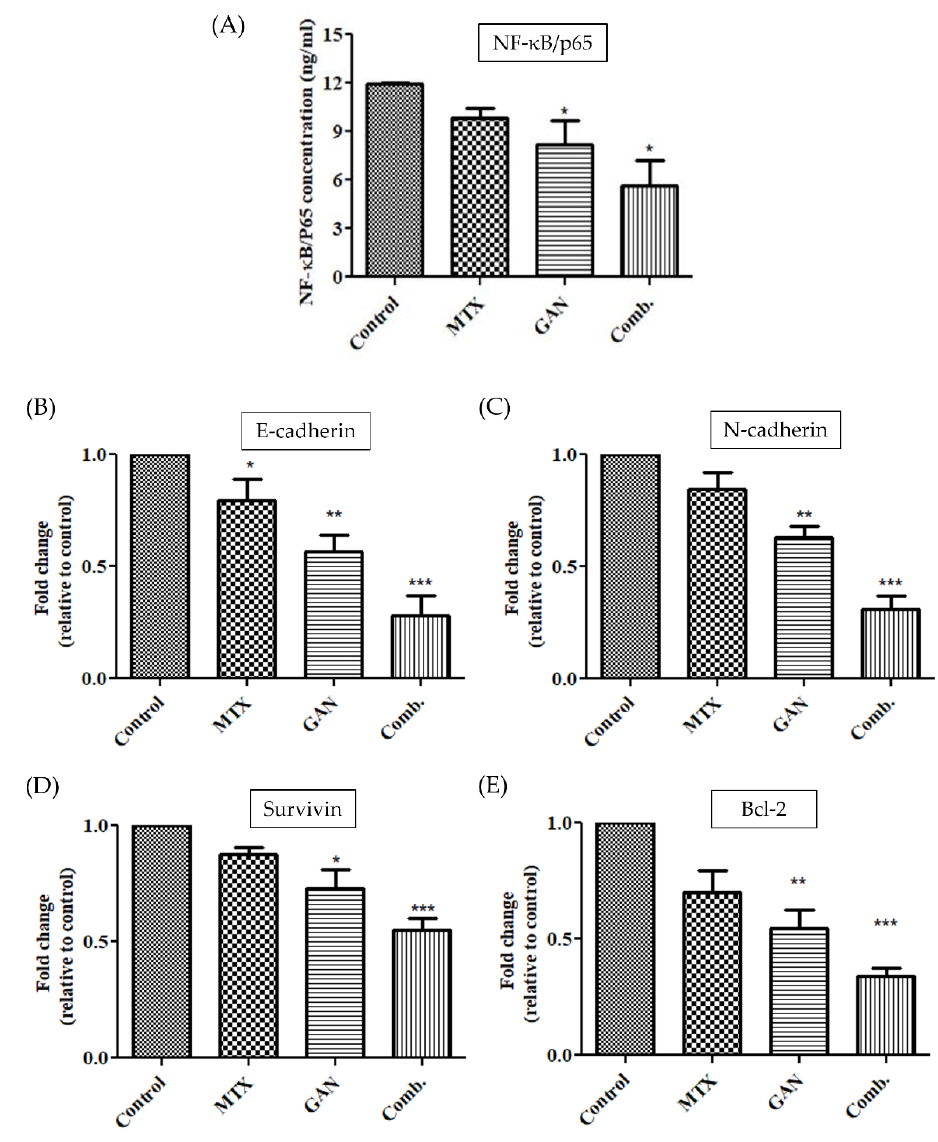
Figure 5. Effects of GAN and MTX alone or in combination on ( A ) concentration of NF- κB/p65; ( B ) mRNA expression of E-cadherin; ( C ) mRNA expression of N-cadherin; ( D ) mRNA expression of survivin; ( E ) mRNA expression of Bcl-2. * p < 0.05, ** p < 0.01 and *** p <